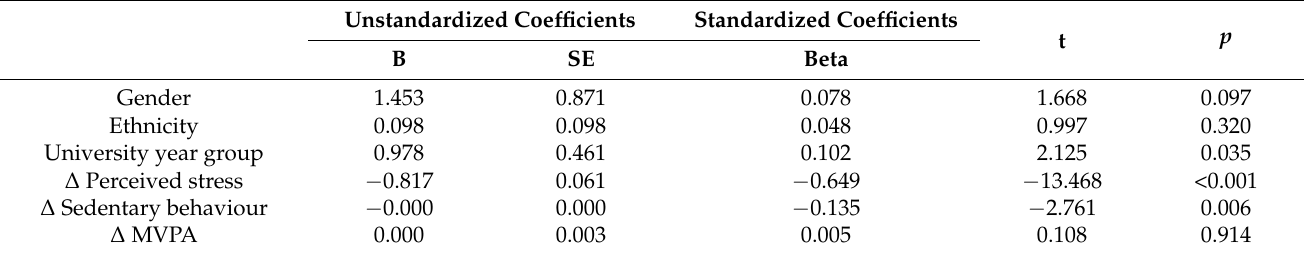
Table 2. Multiple regression model displaying factors associated with Δ mental wellbeing.